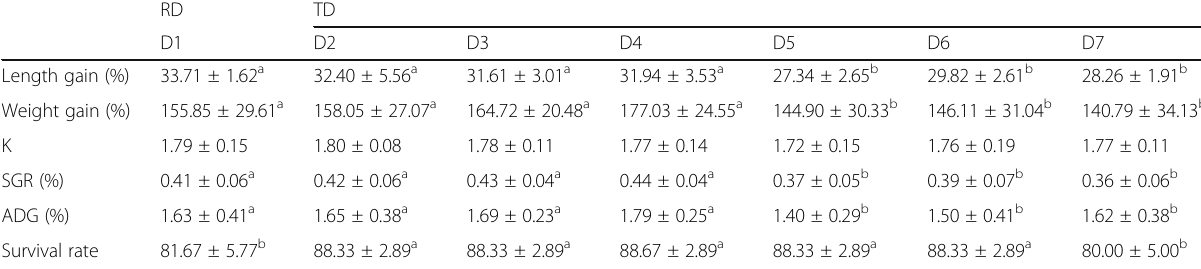
Table 3 Growth parameters, condition factor and survival rate of L. rohita fingerlings after 100 days feeding